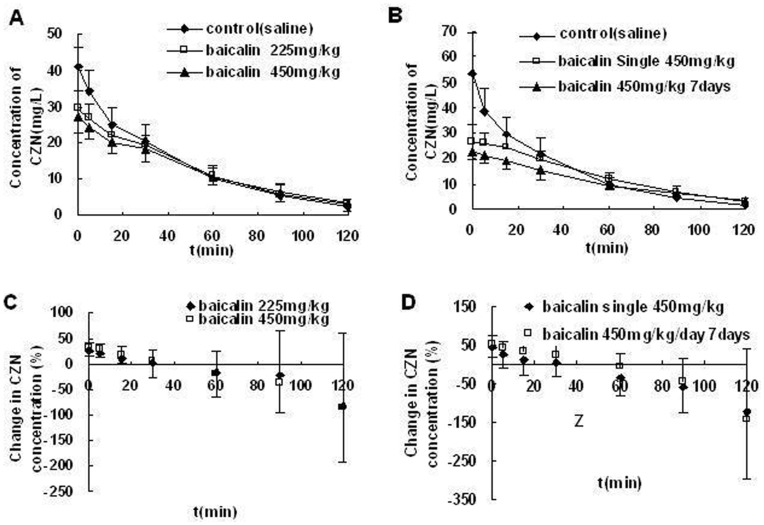
Effect of baicalin treatment on CZN pharmacokinetics.(A) (B)The concentration-time profile of CZN (15 mg/kg,iv) after treatment with saline (control) or baicalin in rats. (C) (D) The changes in CZN (15 mg/kg, i.v) concentrations (%) after treatment with baicalin compared with control. (A) (C) treatment with baicalin (225 or 450 mg/kg, i.v). (B) (D) 1 day-treatment or 7 day-treatment with baicalin (450 mg/kg/day, i.v). Each point represent the mean±SD (n = 9).